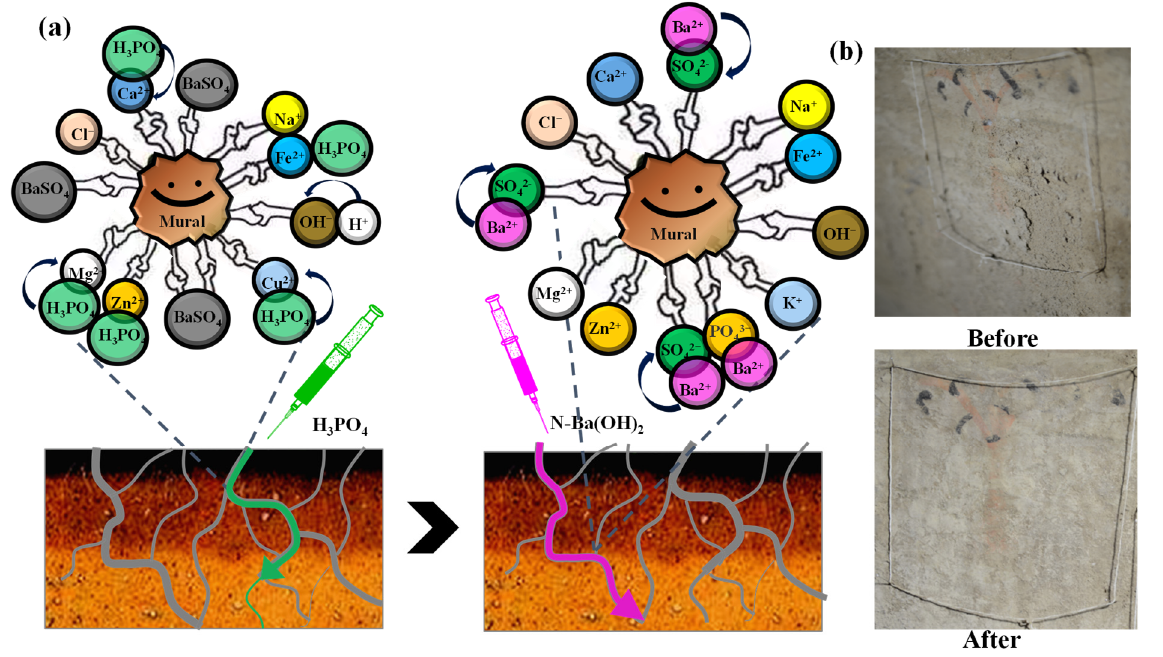
Figure 2. ( a ) Reaction mechanism of desalination and consolidation of tomb murals. ( b ) Application to tomb murals in Jiangxi, China.